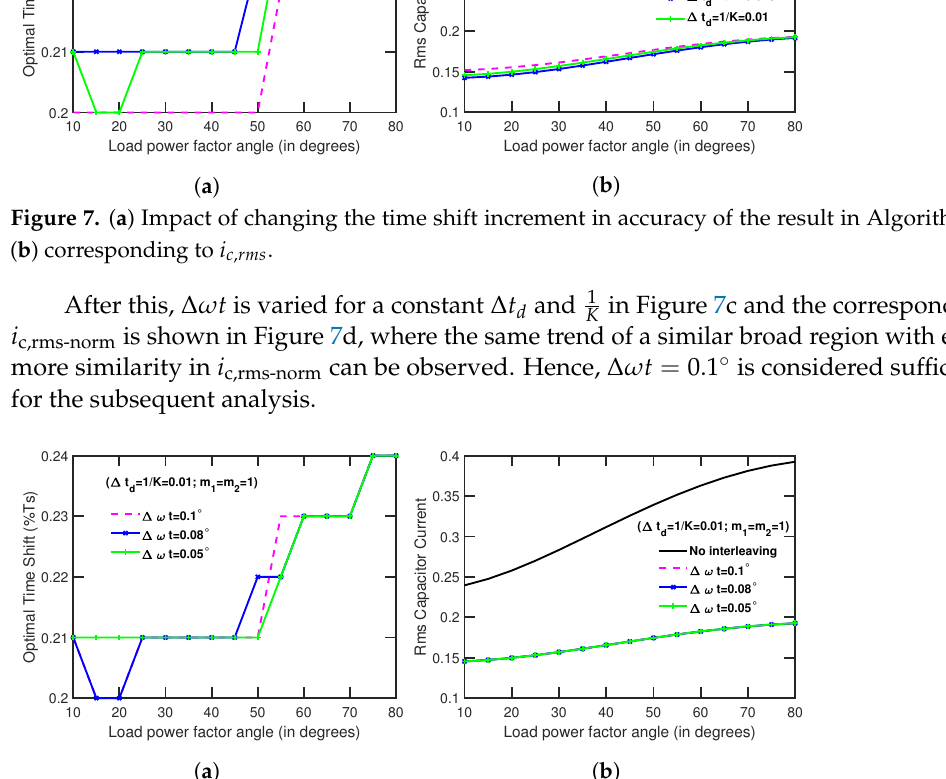
Figure 8. ( a ) The impact of changing the angular increment in accuracy of the result in Algorithm 1, ( b ) corresponding to i c , rms